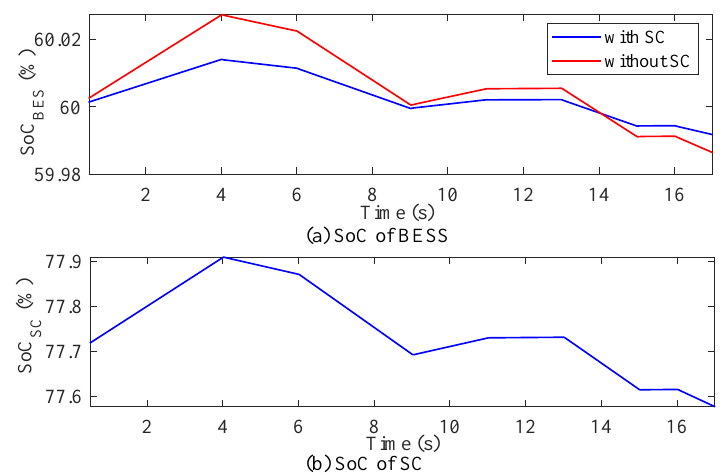
Figure 8. State of charge (SoC) responses for both BESS and SC under surplus and deficit power modes with step changes in the solar